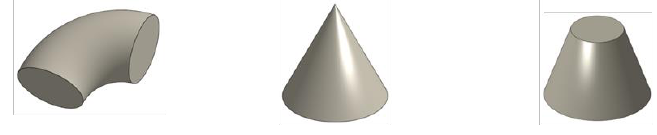
Figure 9. Basic type parts: elbow, cone, and truncated cone.